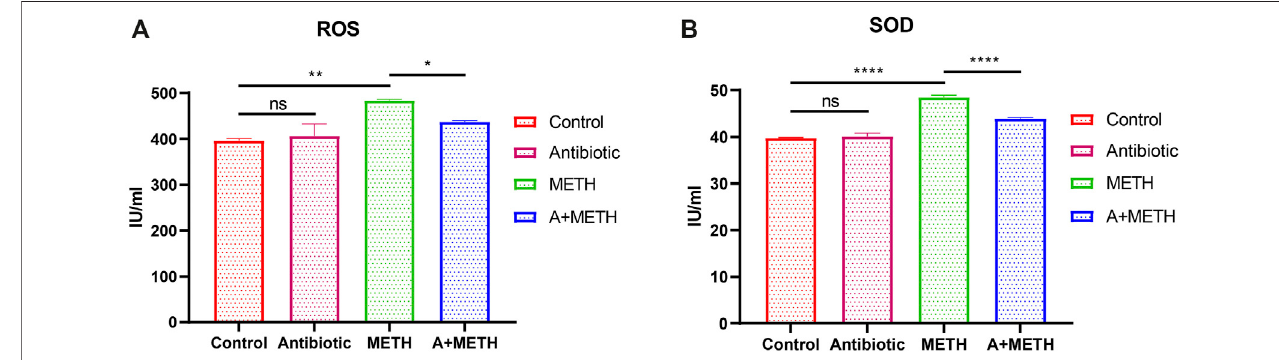
FIGURE 2 | Analyses of ROS and SOD activities. The treatment with METH signi fi cantly increased ROS (A) and SOD (B) activities, which signi fi cantly repressed with antibiotic pretreatment. Antibiotics alone did not change compared to the control group. * p < 0.05; ** p < 0.01; *** p < 0.001; ns, statistically non-signi fi